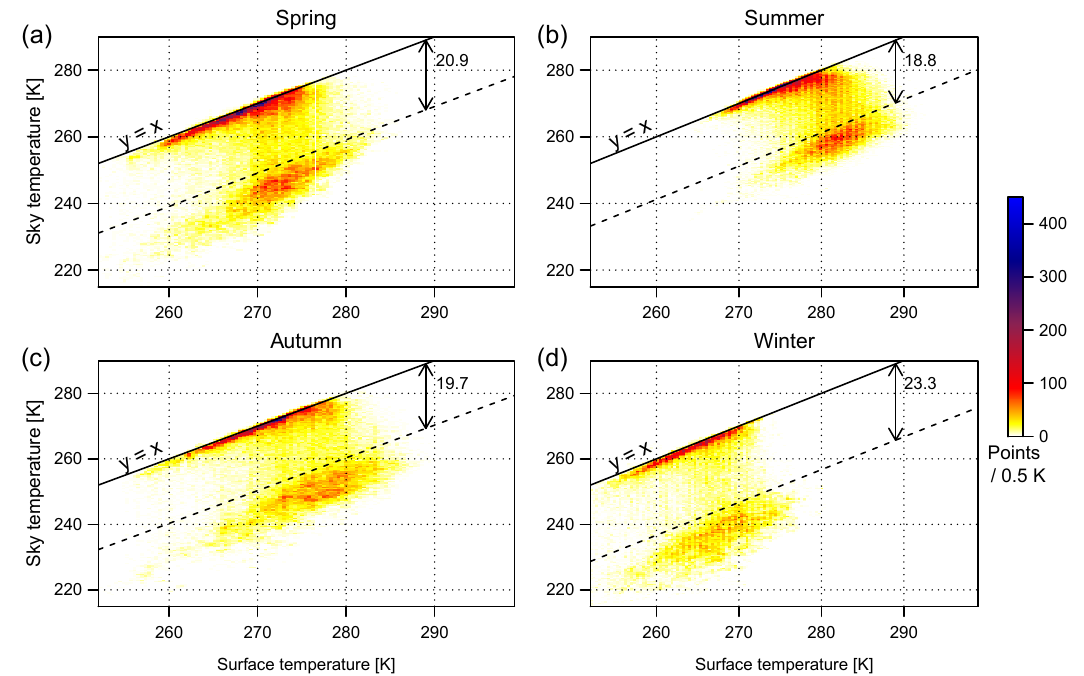
Figure 6. Comparison of daytime sky and ground temperatures at Weissfluhjoch station (2690m) in Switzerland, per season, using data from 1994 to 2010. The upper cluster corresponds to in-cloud and overcast conditions, whilst the lower one corresponds to clear-sky times. The points in between are partially cloudy conditions. The dashed line corresponds to the automatically detected threshold under which values are considered as being part of the lower